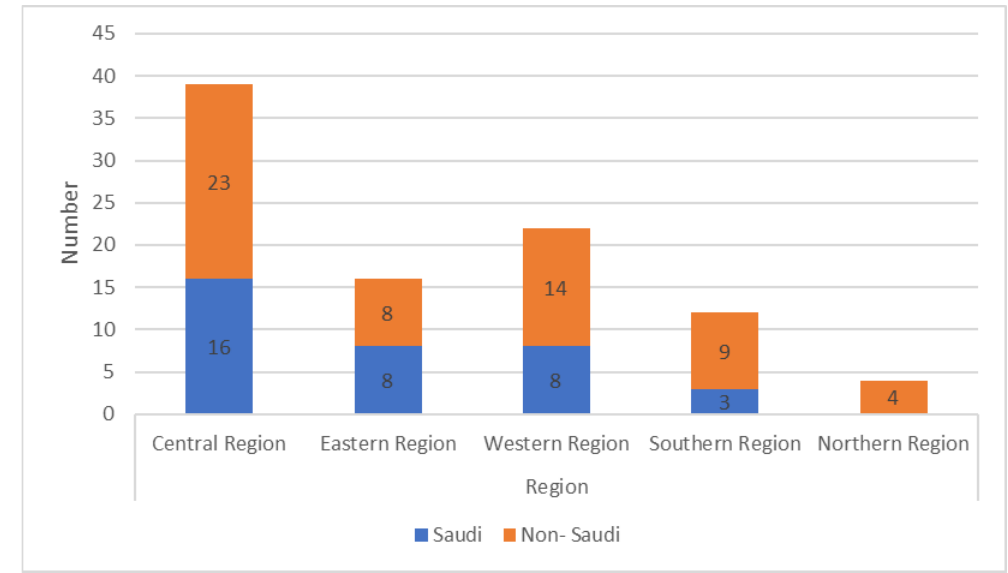
Healthcare 2022 , 10 , 2220 Figure 1. Distribution of respondents from different regions of Saudi Arabia. Figure 1. Distribution of respondents from different regions of Saudi Arabia.